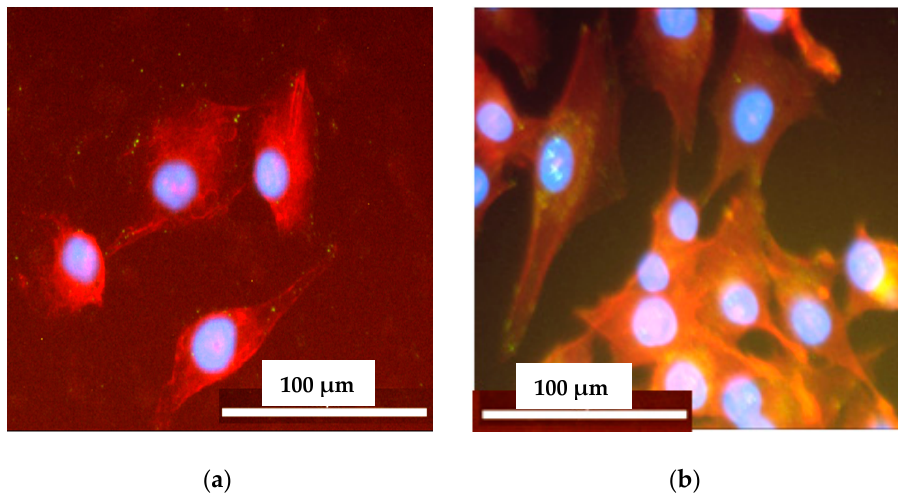
Figure 11. The cell attachment to the selected samples surface: PU-I ( a ) and PU-II-2 ( b ) after 72 h of the test. Cells were simultaneously stained with DAPI (blue) for nucleus visualization and Phalloidin TRITC (red) for actin viability.